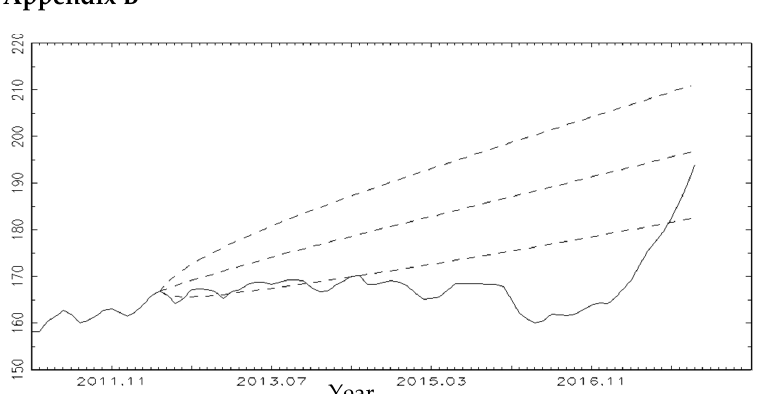
Figure A1. Time series forecasting for CPI, the in-sample January 2000–May 2012, and the out-of-